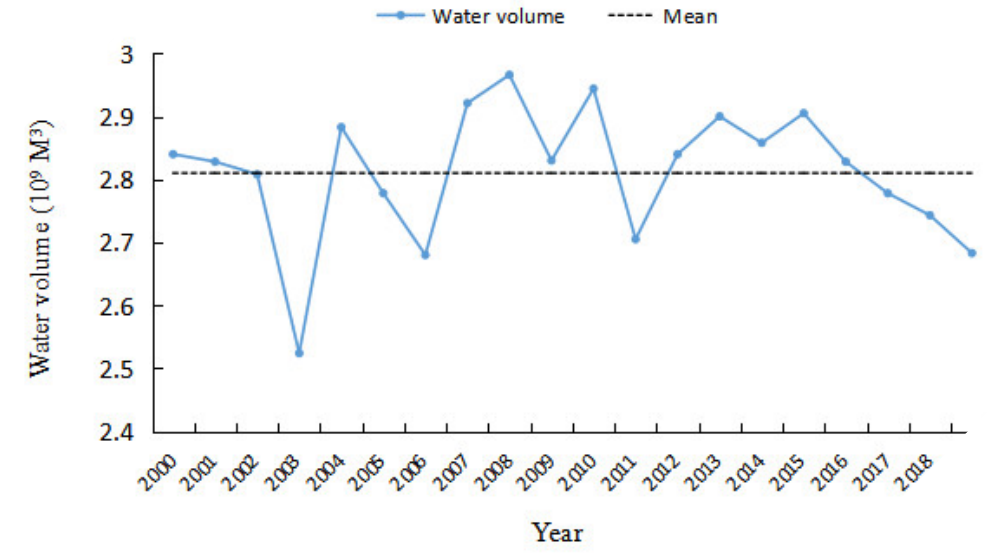
Figure 2. Changes in the water volume of Erhai Lake in December from 2000 to 2019. The average monthly water volume of Erhai Lake from 2000 to 2019 showed that the annual cycle of monthly water storage of Erhai Lake (Figure 3) oscillated from a minimum value in July (2.62 × 10 9 m 3 ) to a maximum value in November (2.981 × 10 9 m 3 ), with an average of 2.788 × 10 9 m 3 . During the year, the water volume first decreased and then increased; specifically, it decreased from January to July and increased from August to